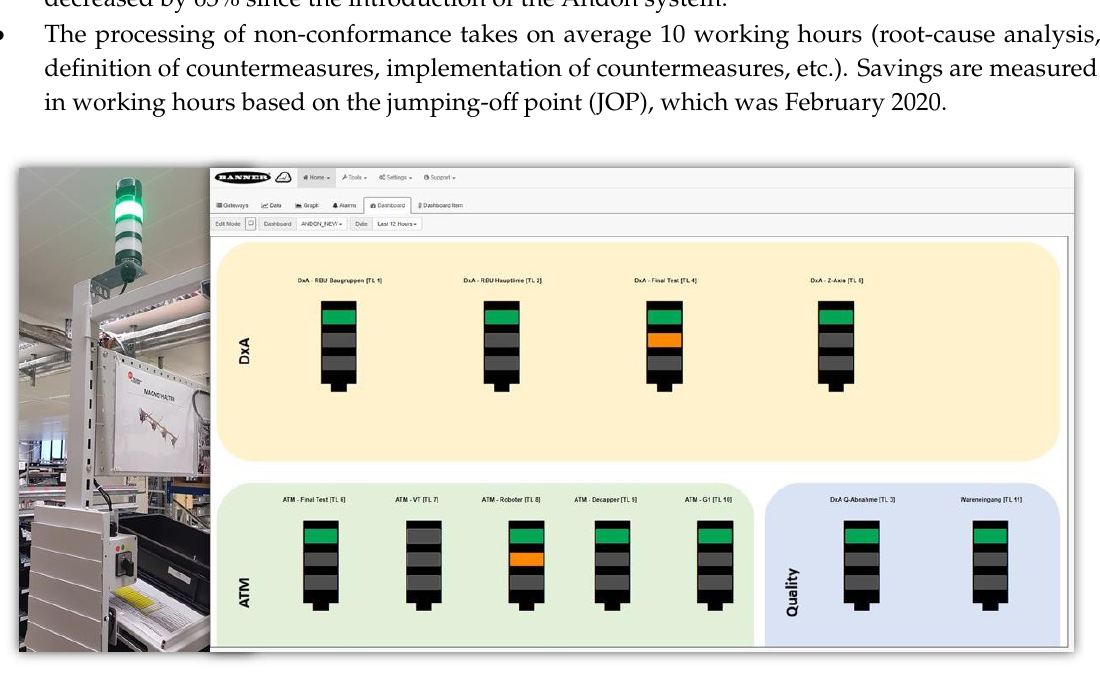
Figure 7. Implementation of the Andon system. Table 4. Andon system — quantitative results. JOP: jumping-off point.